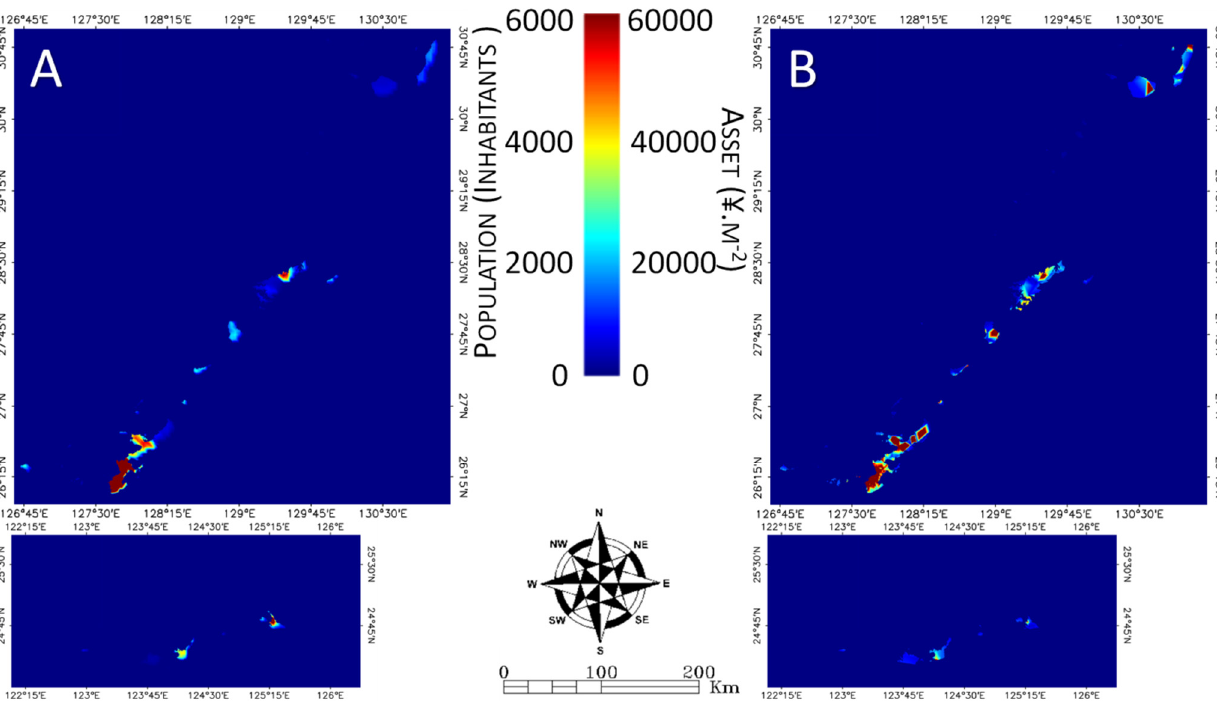
Figure 5. Nansei maps of the time-averaged ( A ) population (2000, 2005 and 2010), and ( B ) asset (2002–2012, yearly) endogenous socio-economic factors. The population is the trivial number of inhabitants, while the asset variable is represented by the land price (¥ · m − 2